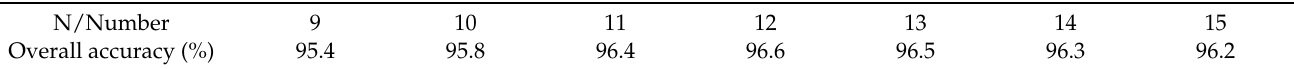
Table 3. Enhanced classification accuracy with different N values.